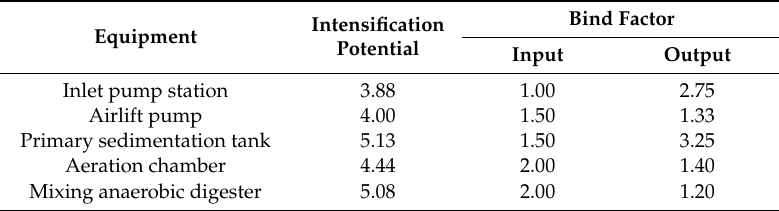
Table 12. Overall assessment of the complexity of the analyzed